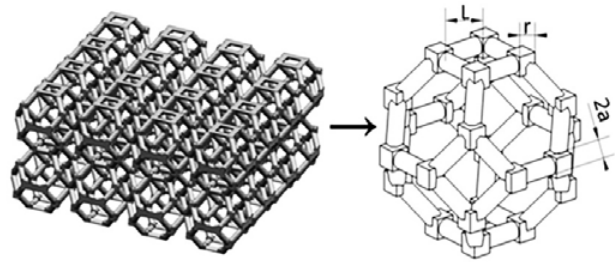
Figure 2. Schematic drawing of the 3D Boomsma ‐ Poulikakos (B ‐ P) model.